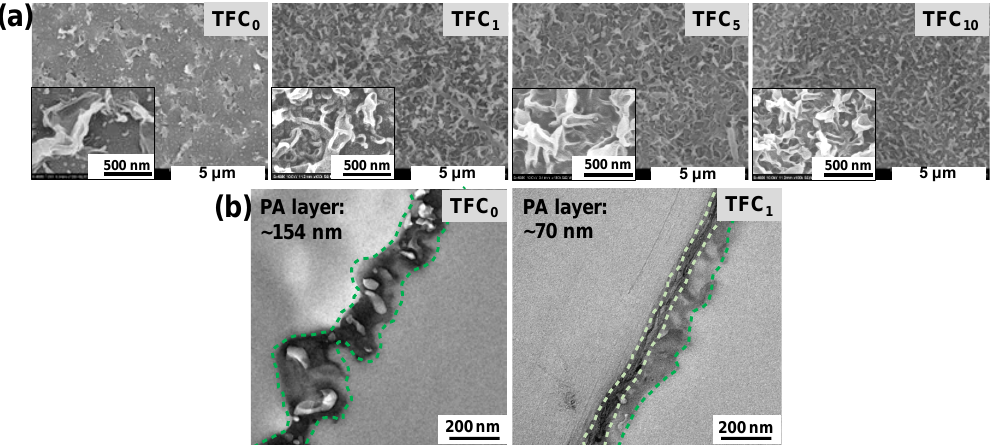
Figure 4. Morphology characterization of TFC membranes with SWCNTs interlayer. ( a ) surface SEM images with insets of images magnification × 10.0 K and ( b ) cross-sectional TEM images of TFC 0 and TFC 1 membranes.